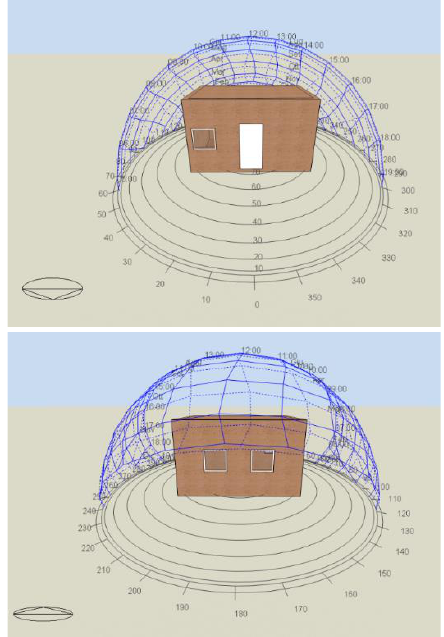
Figure 6. Front and rear views of the reference Sustanzeb model implemented in EnergyPlus.